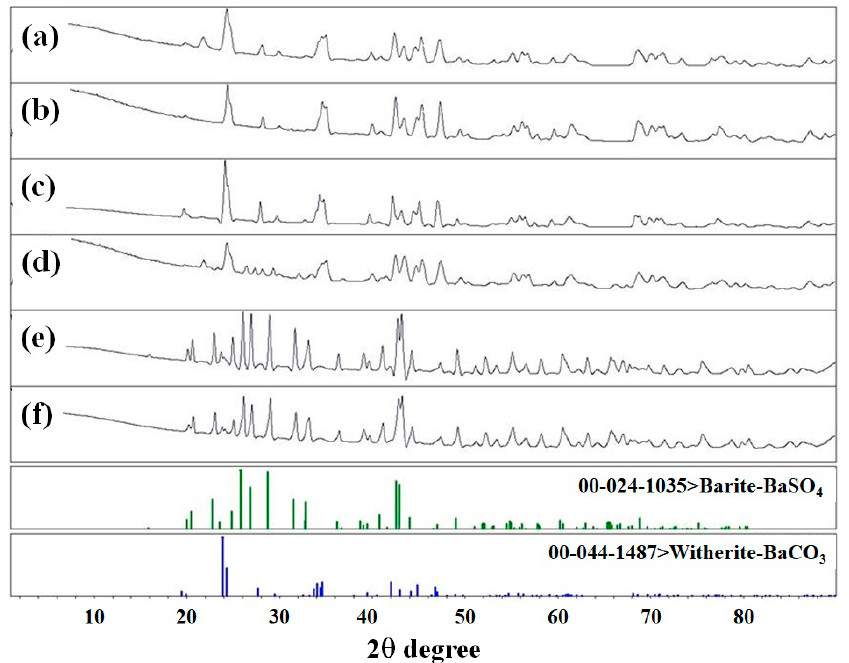
Figure 1. XRD pattern of before sulfate adsorption ( a ) PCL/Ba (50/50), ( b ) PCL/Ba (2.5/97.5), and ( c ) PCL/Ba (10/90), and after sulfate adsorption ( d ) PCL/Ba (50/50), ( e ) PCL/Ba (2.5/97.5), and ( f ) PCL/Ba (10/90).